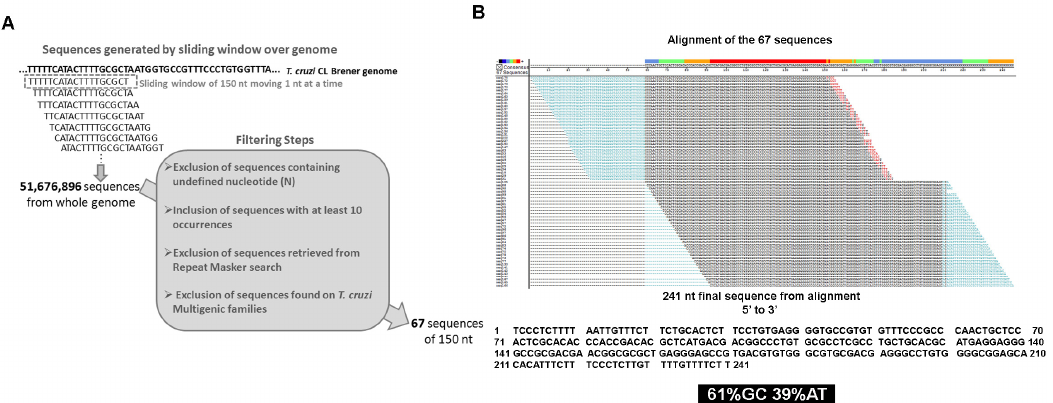
Figure 1. Strategy to identify a novel repetitive element in the T. cruzi CL Brener genome. ( A ) Schematic representation of the 150 nucleotide (nt) sliding window used to generate sequences covering all of the CL Brener genome and filtering steps used to exclude known repetitive elements. ( B ) Alignment of the 67 sequences of 150 bp obtained after the filtering steps that resulted in the consensus sequence of 241 nucleotides of the repetitive element.